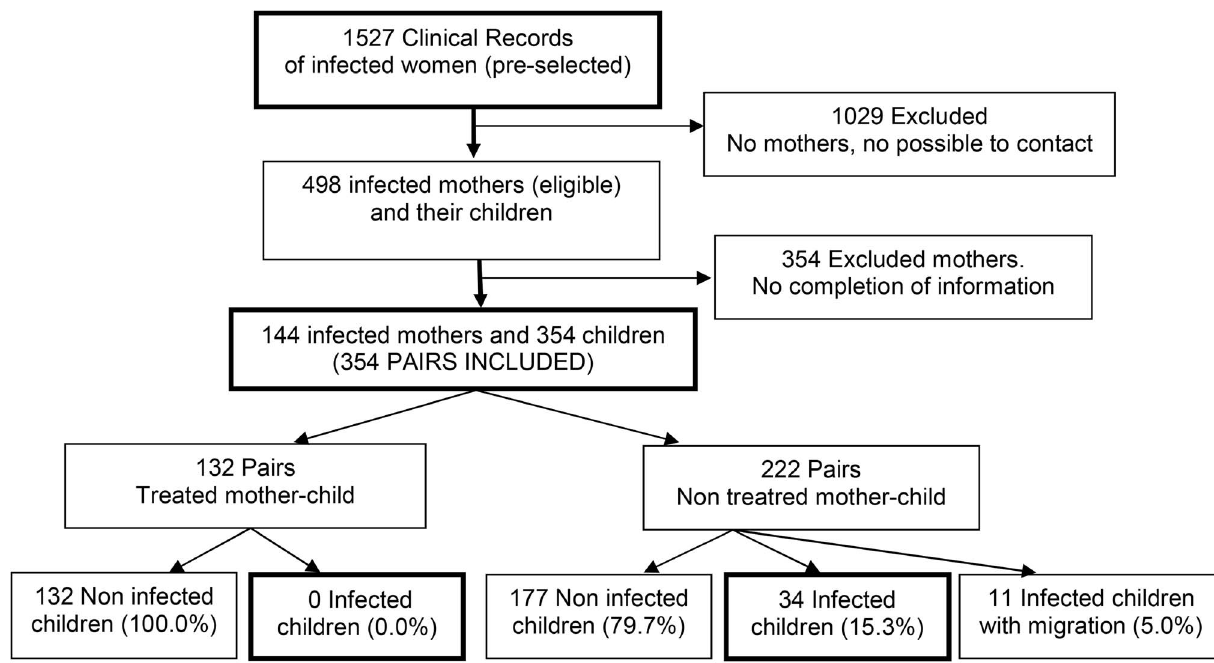
Figure 1. Flowchart of the study.